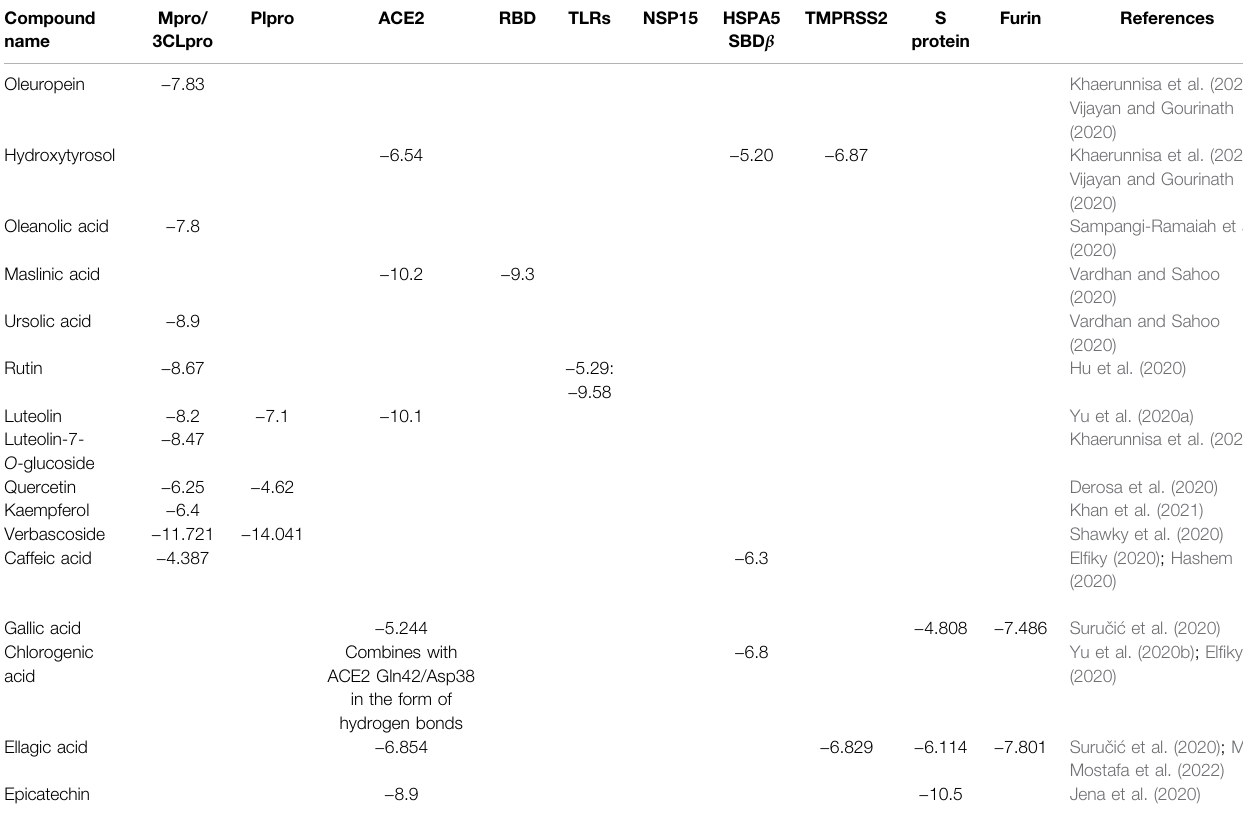
TABLE 1 | Binding af fi nity (Kcal/mole) scores of olive leaf compounds against several targets in